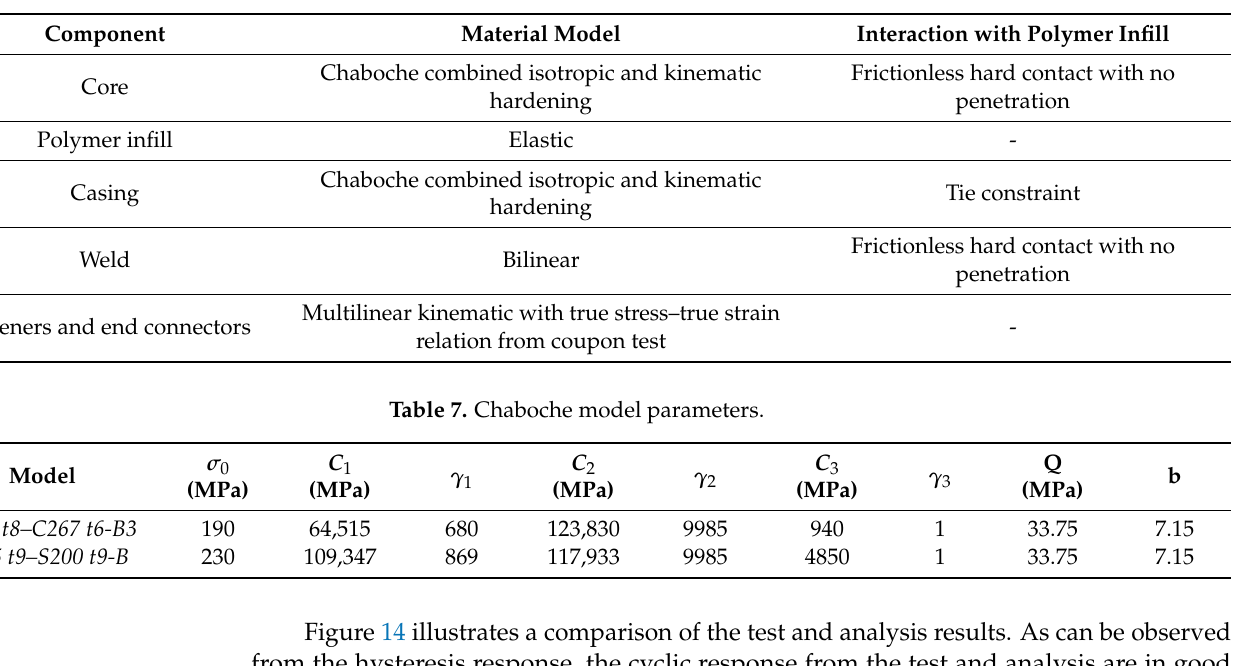
Table 6. Material model and interaction properties.